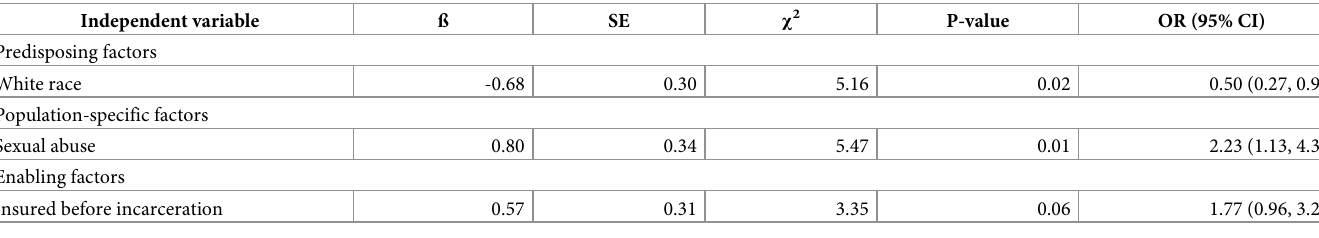
Table 4. Logistic regression model for dependent variable up-to-date Pap test, N = 290 a . Independent